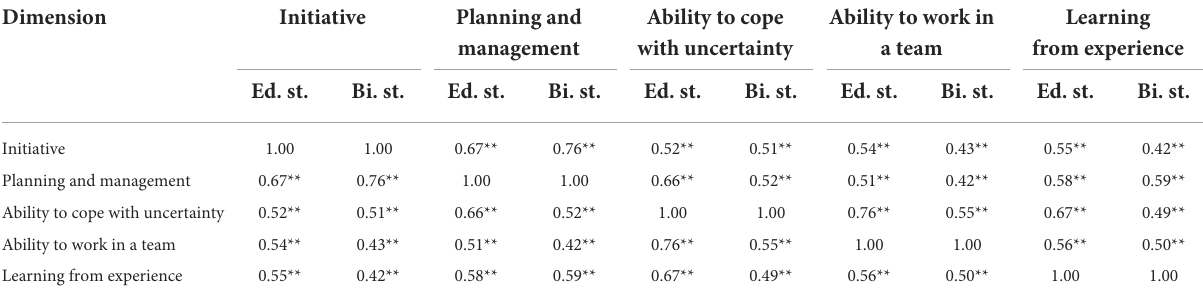
TABLE 9 Spearman’s rank correlation between all dimensions of the initiative and action orientation sub-competence. Dimension Initiative Planning and